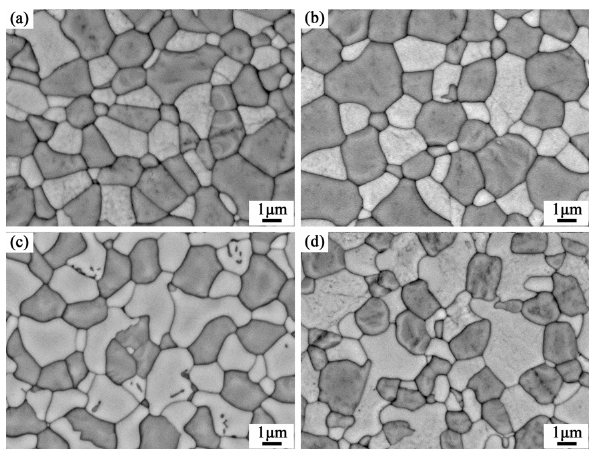
Fig. 20 Backscattered electron images of thermal-etched surfaces of La 2– x Lu x Zr 2 O 7 ceramics: (a) x = 0.6, (b) x = 0.8, (c) x = 1.0, and (d) x = 1.2. Reproduced with permission from Ref. [49], © Elsevier Ltd. 2014.